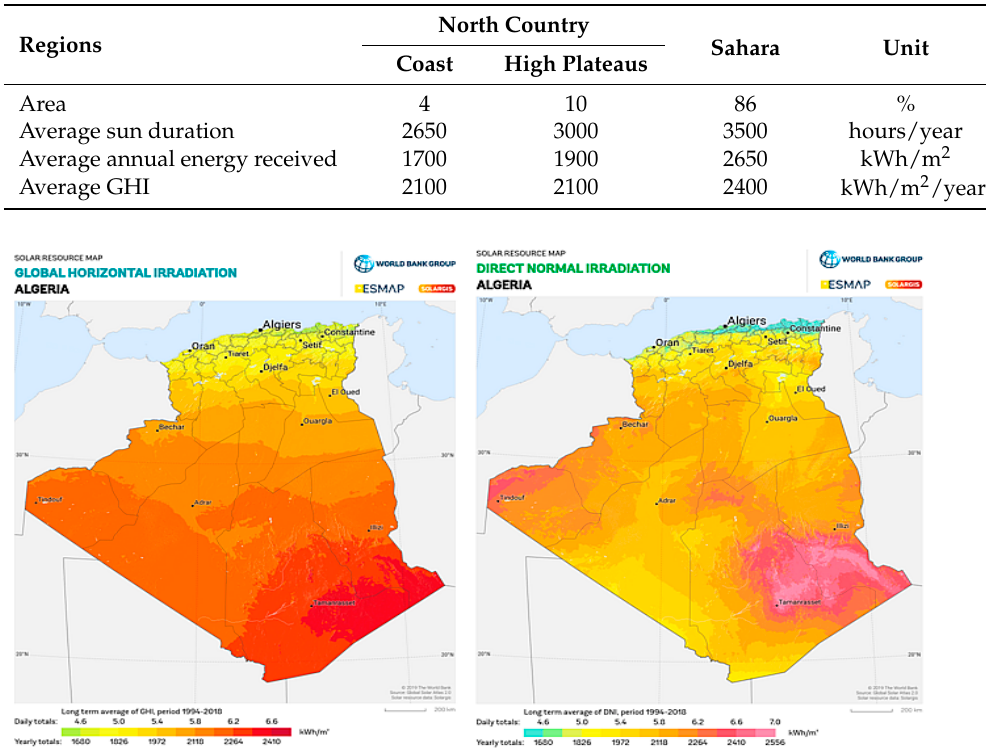
Table 12. Solar potential in Algeria [54].